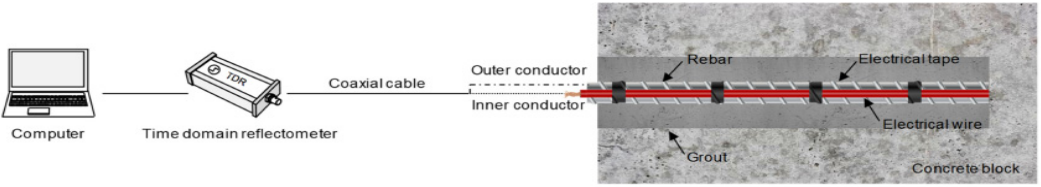
Figure 14. Smart sensing system for measuring electromagnetic waves in rock bolts [2].